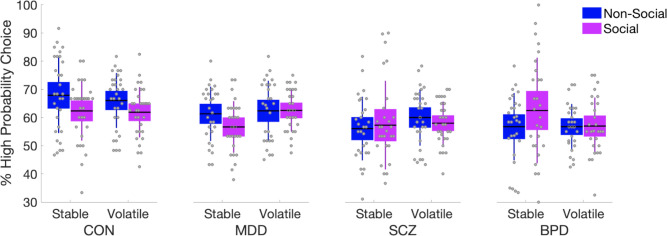
Proportion of trials where the better option was chosen.The better option was defined to be the one that according to the ground truth probability schedule was more likely to be rewarded. Importantly, ‘better’ choice according to color and according to social cue could be different in the same trial. Patients with SCZ and BPD showed poorer response quality in the task compared to HC. A Group x Cue interaction analysis showed that response quality was higher for the non-social cue for HC and MDD patients, whereas BPD patients showed the opposite pattern. Means are plotted with boxes marking 95% confidence intervals and vertical lines showing standard deviations. See also S6 Table.